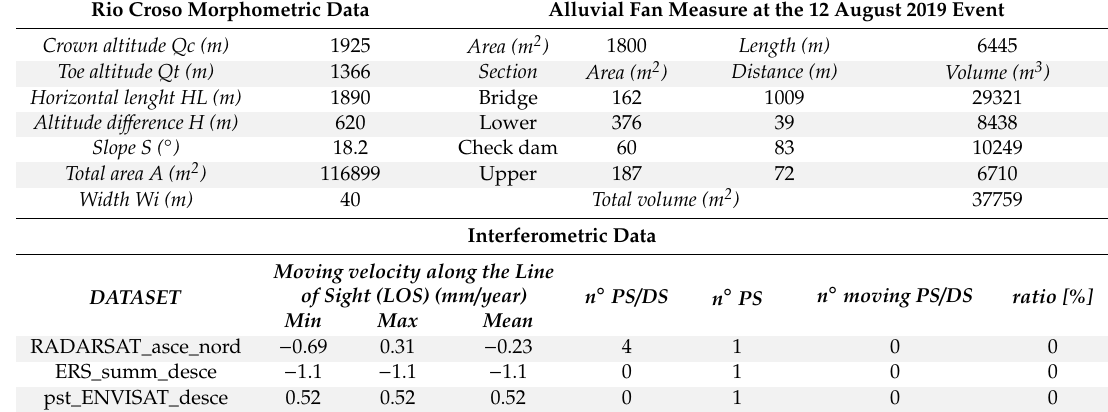
Table 4. Rio Croso morphometric data and morphometry of the alluvial fan including the estimation of the debris volume after the 12 August 2019 event. The presented information include original data and data retrieved from IFFI and Arpa Piemonte-SIFraP-Sistema Informativo Frane in Piemonte. Interferometric data (ERS for the time interval 1993–2001; RADARSAT for the time interval 2003–2009; ENVISAT for the time interval 2003–2010) for the Croso stream (from Arpa Piemonte-SIFraP Sistema Informativo Frane in Piemonte). Line Of Sight (LOS); Permanent Scatter (PS); Distributed Scatterer (DS). Rio Croso Morphometric Data Alluvial Fan Measure at the 12 August 2019